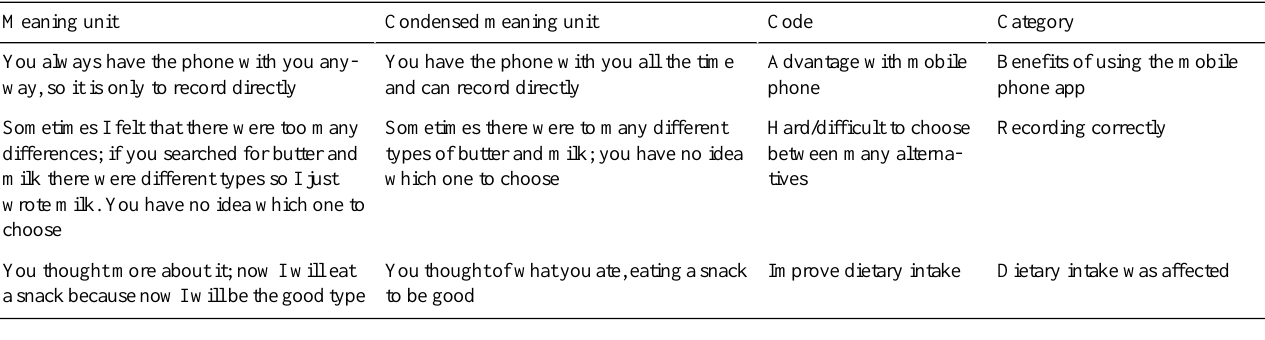
Table 1. Examples of meaning units, condensed meaning units, codes, and categories.